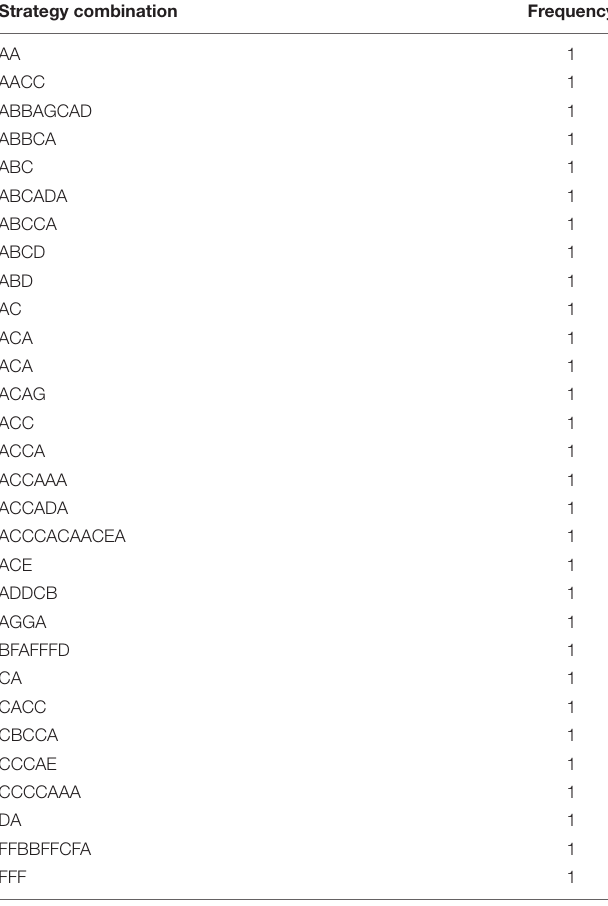
TABLE 4 | Strategy combinations in the corpus. TABLE 5 | Combination patterns of apology strategies.